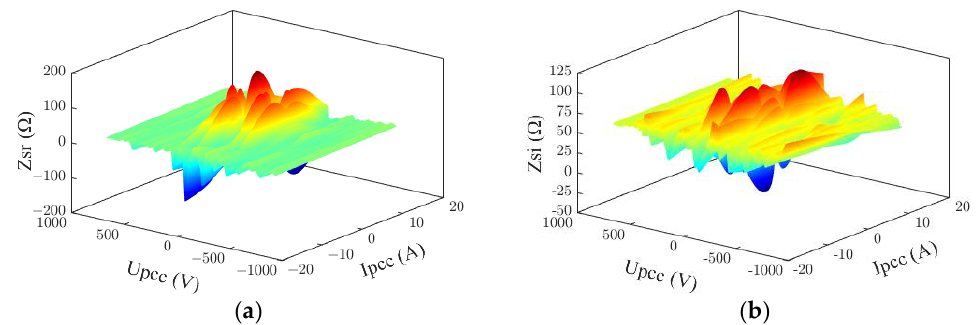
Figure 19. Results of method 3 in 3rd harmonic. ( a ) Result of real part; ( b ) Result of imaginary part. Table 6. Evaluation indexes of method 3 in 3rd harmonic.